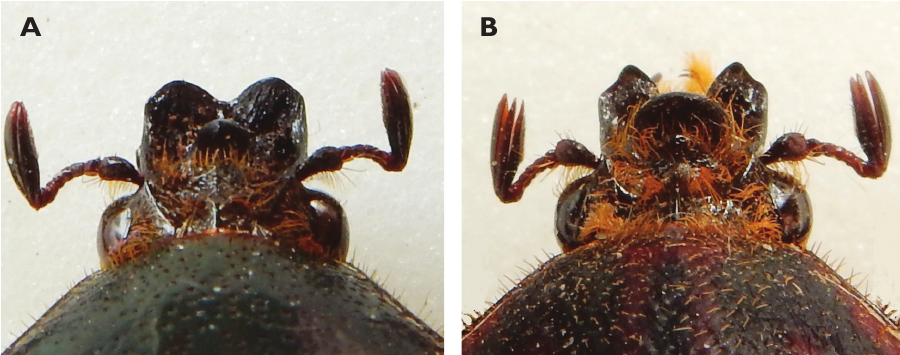
Figure 2. Clypeal armour of A Lamellothyrea descarpentriesi (Marracuene, Mozambique) and B Lamel- lothyrea isimangaliso sp. n. (St Lucia, South